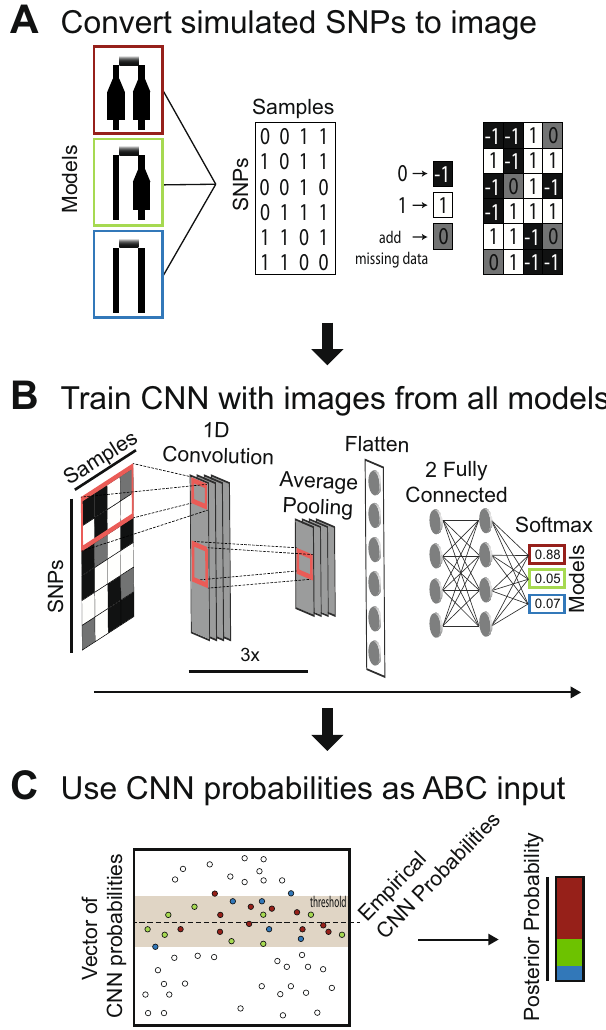
Fig. 3 Graphic representation of the implemented convolutional neural network-approximate Bayesian computation (CNN-ABC) approach for model selection. A We converted the simulated genetic data (10,000 simulations per scenario) to images, using the lowest value ( − 1; black pixels) for the reference state, the highest value (1; white pixels) for the alternative state, and an intermediate value (0; gray pixels) for the missing genotypes, which were randomly added according to the percentage of missing data observed in each species. B Each obtained image is then fed into a CNN that is trained to recognize images generated by simulations from each scenario (details on the CNN architecture in the Supplementary Information). C The vectors of CNN probabilities obtained for simulations from each scenario and for the empirical dataset are then used as summary statistics to perform an ABC step, by using a threshold that retains only the most similar